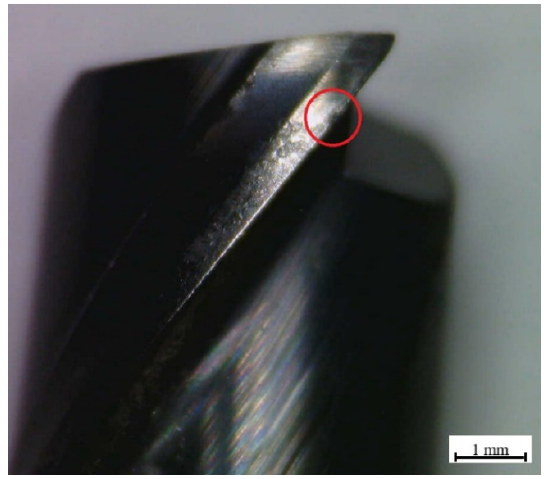
Figure 7. 90 ‐ degree angle cutting tool ‐ chipping.